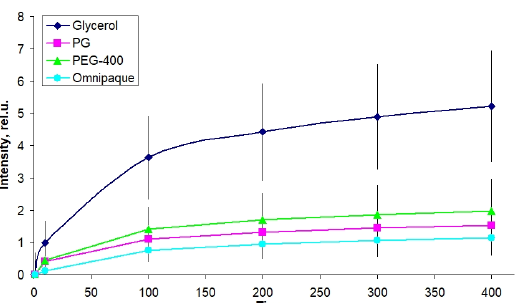
Figure 2. Kinetics of the intensity of optical transmission measured at 700 nm wavelength for cartilaginous samples immersed in 30% water ‐ based solutions of optical clearing agents. The results are averaged over various thicknesses: 1.4 ± 0.4 for the glycerol, 1.1 ± 0.3 for PG, 1.1 ± 0.3 for PEG ‐ 400 and 1.5 ± 0.3 for Omnipaque. The maximum rate of optical clearing is observed for immersion in glycerol; the intensity of the transmitted radiation increased five ‐ fold in the first 400 s of immersion. However, the data scattering for this group is also quite high; the relative deviation from the average is as much as 0.5. The curves for PG, PEG ‐ 400 and Omnipaque are more uniform and almost overlap taking into account the data scattering. The corresponding effective diffusion coefficients reflecting the rates of optical clearing during immersion in